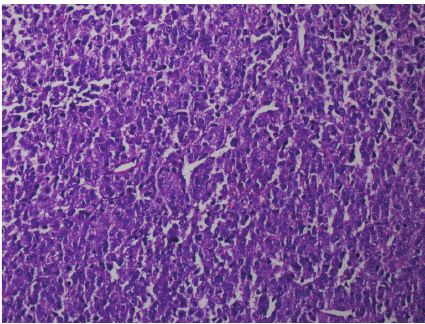
Figure 2: Tumor cells composed of large epithelioid cells with no melanin pigment (HE × 200).